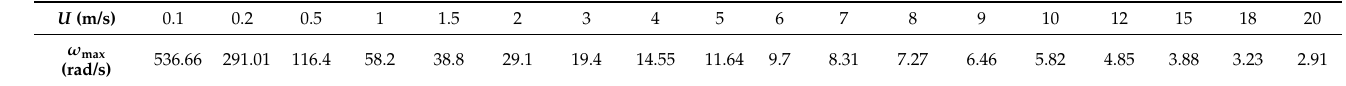
Table 2. With different wind speeds.